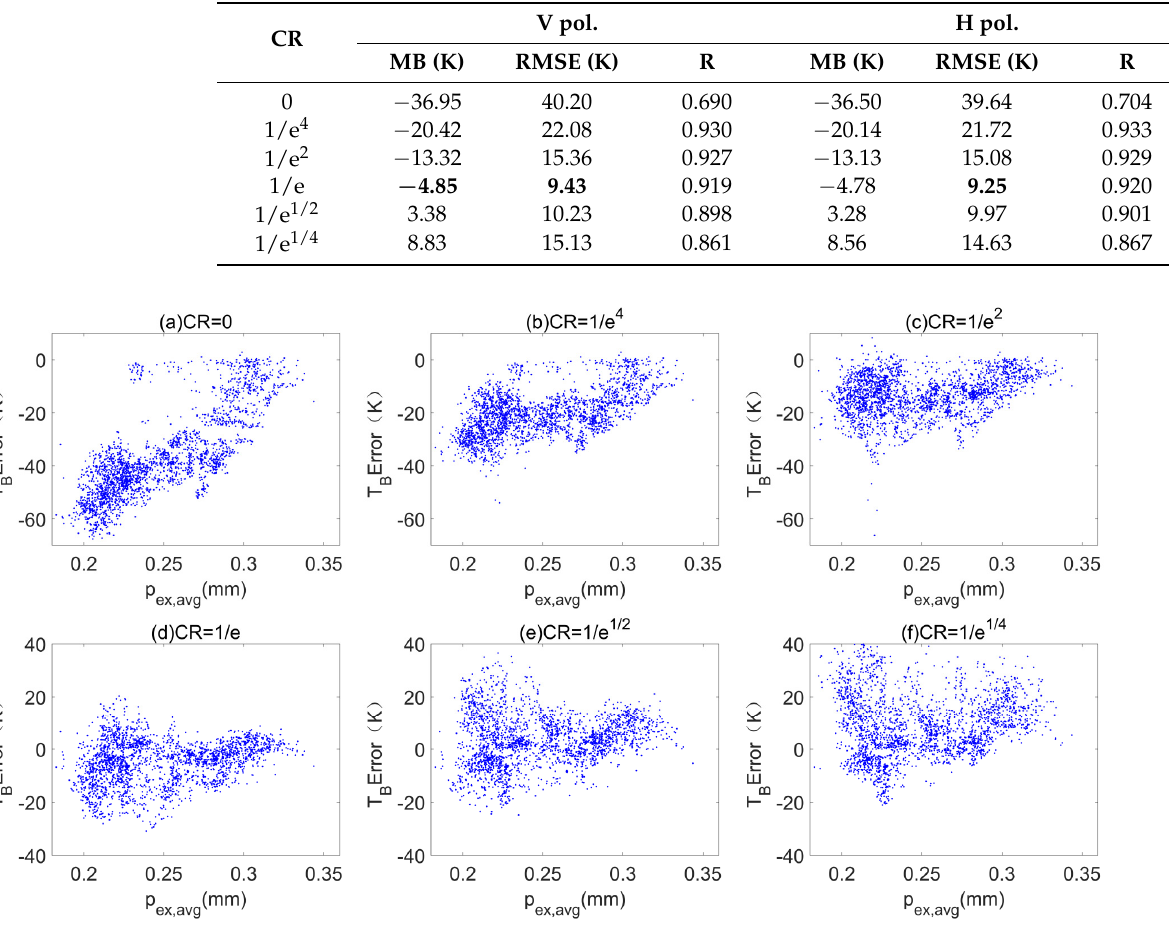
Figure 14. Sensitivity of brightness temperature (T B ) Error to mass-weighted average exponential correlation length ( p ex,avg ) using different penetration depth cut-off thresholds (CR) at 89 GHz, vertical polarization, and a 55° incidence angle.